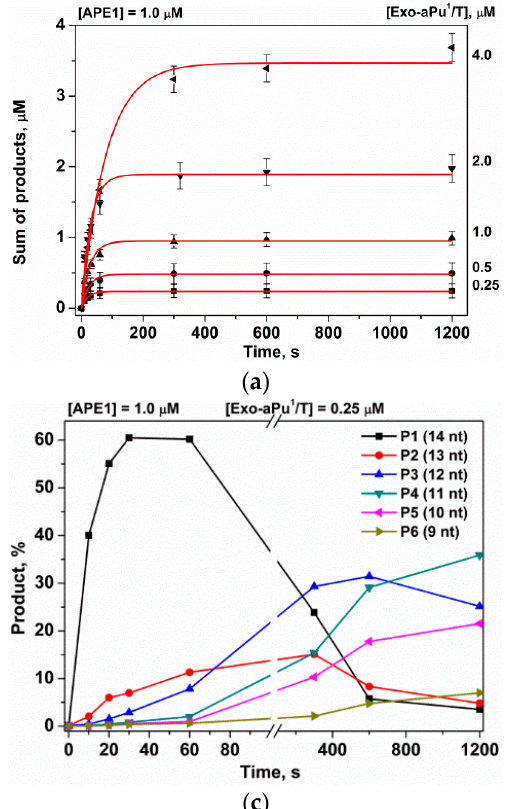
Figure 4. Kinetics of the accumulation of DNA products during an interaction with APE1 as detected by PAGE. ( a ) Accumulation of the total reaction products at various concentrations of substrate Exo-aPu 1 /T , ( b ) sequential formation of reaction products, and ( c ) the accumulation and consumption of intermediate truncated reaction products P n during sequential exonuclease removal of 3 ′ -end nucleotides.